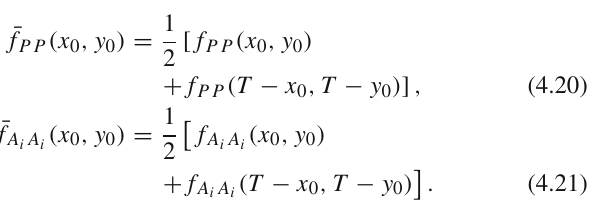
√ t 0 m P measured at